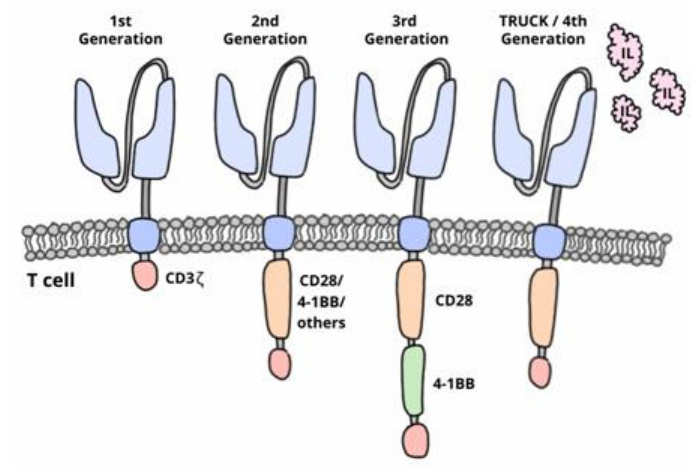
Figure 2. Generations of CAR-T cells.